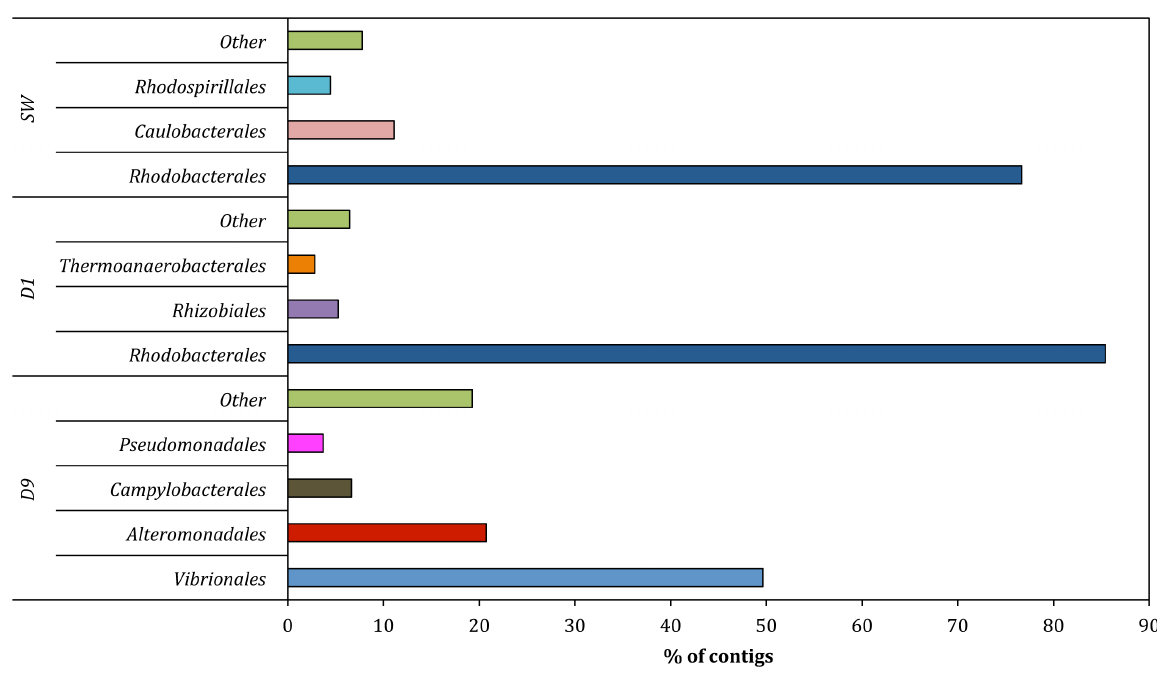
Figure 9. Taxonomic classification of osmotic stress contigs for each analyzed water sample as assigned by MGTAXA. SW- Source water; D1- Produced water day 1; D9- Produced water day 9. Only the top four bacterial orders to which most contigs were assigned to are shown in the figure. The less abundant bacterial orders are grouped as ‘‘other’’.